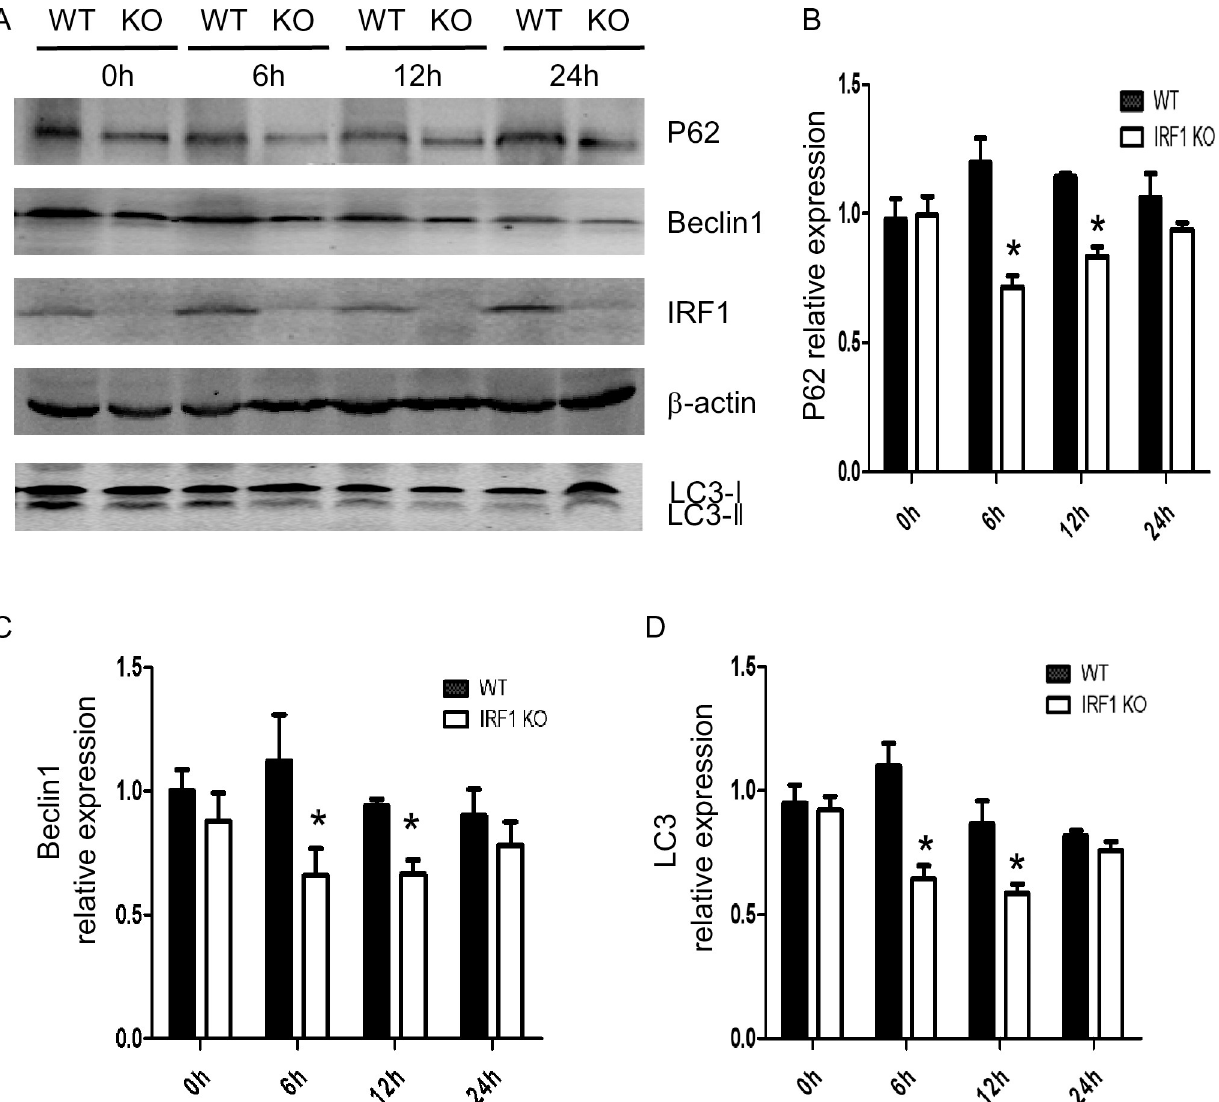
Fig 2. IRF1 induced autophagy and apoptosis in warm IR. A) The proteins of p62, beclin1 and LC3 were detected by Western Blot in livers from WT and IRF1-KO mice (6, 12, 24 h after reperfusion) and densitometric analysis of the relative expression of p62(B), Beclin1 (C) and LC3 (D). n = 3, data are presented as mean ± SD, � P < 0.05 vs. the WT